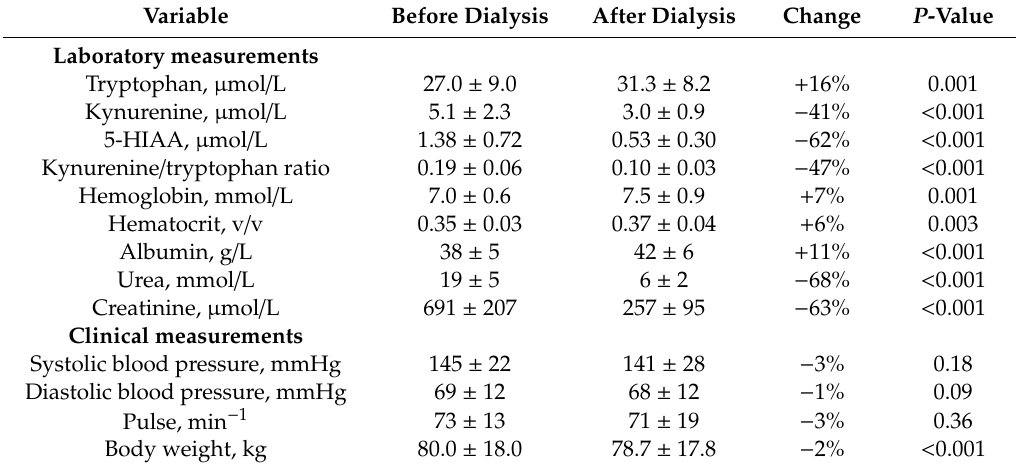
Table 2. Laboratory measurements and clinical measurement before and after